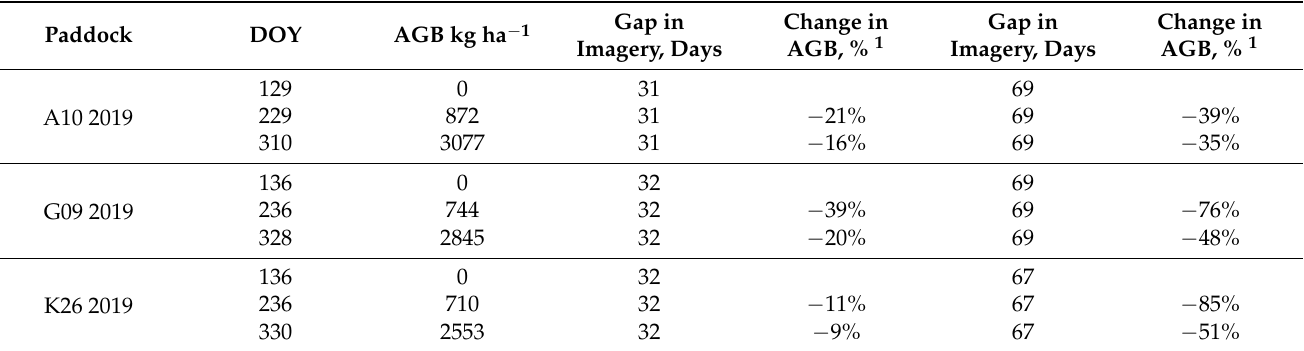
Table 3. Effect of the time-series gap centred at mid-season on estimated AGB.